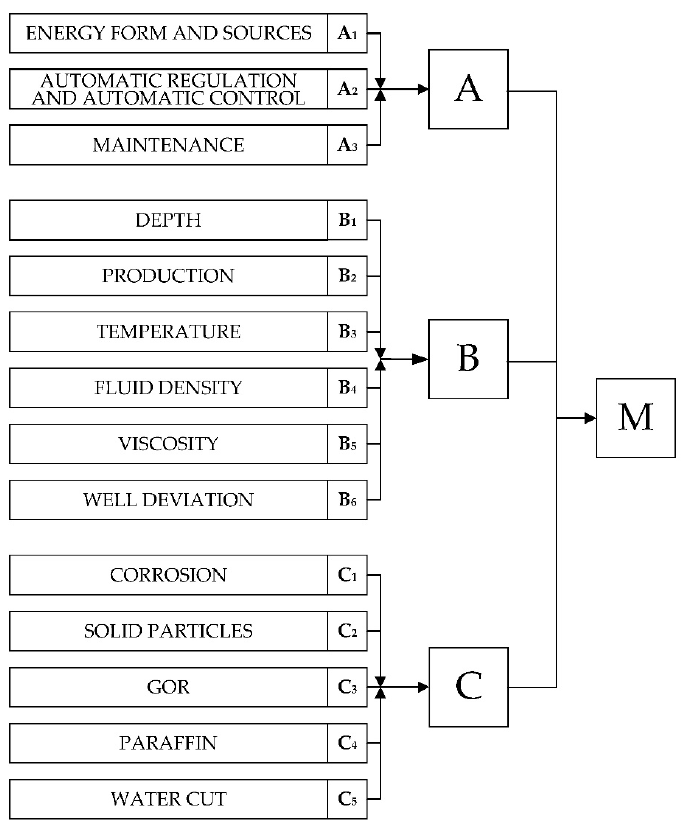
Figure 3. The input parameter structure.